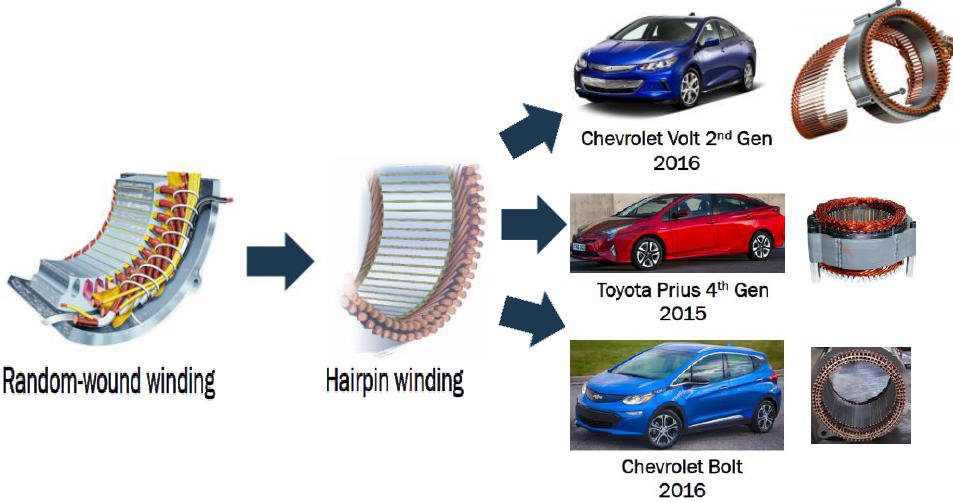
Figure 1. Replacing the conventional round winding with hairpin windings in various electric